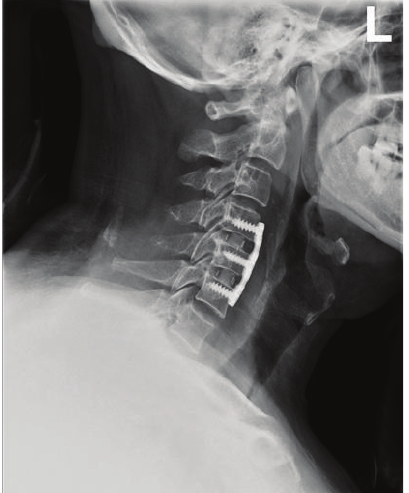
Figure 6: n-HA/PA66 cages in a 62-year-old male postoperatively.